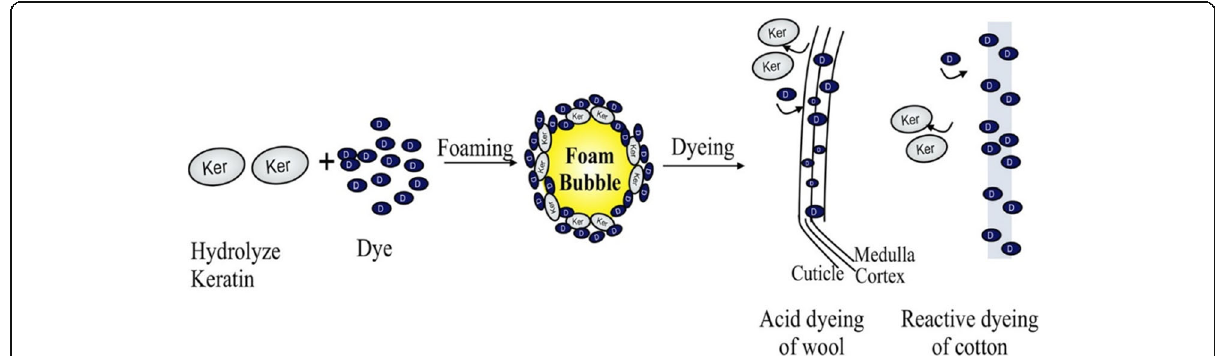
Fig. 6 Hypothetical mechanism for foam dyeing of cotton and wool fabric using keratin hydrolysate [48]. Reprinted with permission